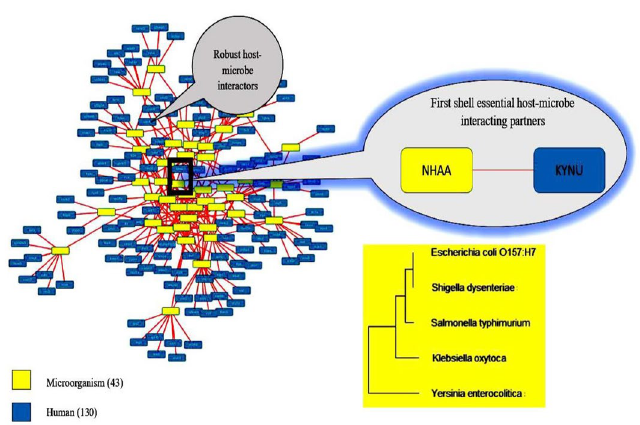
Figure 3. Essential host-microbe interacting proteins.